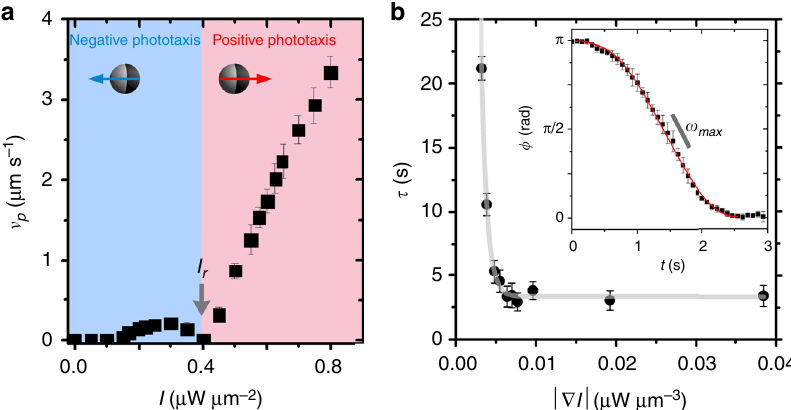
Fig. 7 Light activated motion. a Experimentally measured propulsion velocity v p versus illumination intensity . Below and above I r , particle move with the cap in the rear and the front. In the presence of a light gradient, additional torques are acting on the particle, which leads to negative and positive phototactic motions below and above I r , respectively 37 . b Reorientation time τ as a function of the gradient magnitude | ∇ I |. The solid curve shows a theoretical fi t (see the section “ Methods ” for details). The error bars represent the s.d. (Inset) Time evolution of the angle for an AP within a light gradient | ∇ I | = 0.018 μ W μ m − 3 . The solid curve shows the theoretical fi t (see the section “ Methods ” for details)